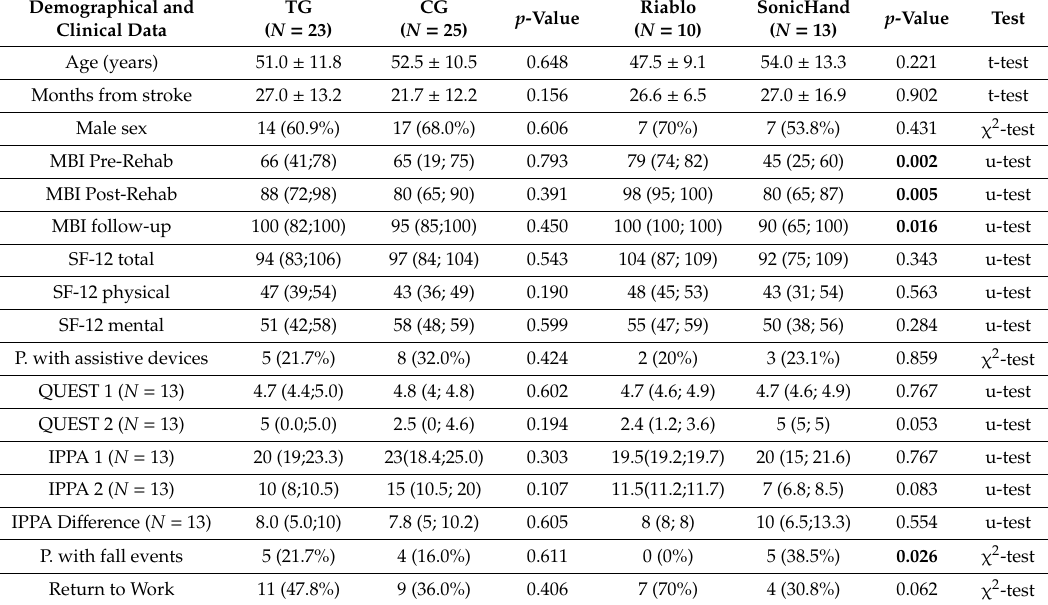
Figure 2. Median MBI-scores at admission, discharge and follow-up for control group (CG) (grey) and technological rehabilitation group (TG) (black).F. Table 1. Patients (P.) data at the follow-up: absolute frequency (and percentages) for discrete variables, mean ± standard deviation for continuous variables, median (and first and third quartiles) for ordinal data. The p -values (in bold if statistically significant) refer to the comparison between patients enrolled in technological group (TG) and those enrolled in the conventional therapy group (CG) in the fourth column and between patients who received Riablo versus SonicHand treatments in the sixth column. These p-values were obtained by the tests reported in the last column and selected according to the variable types.